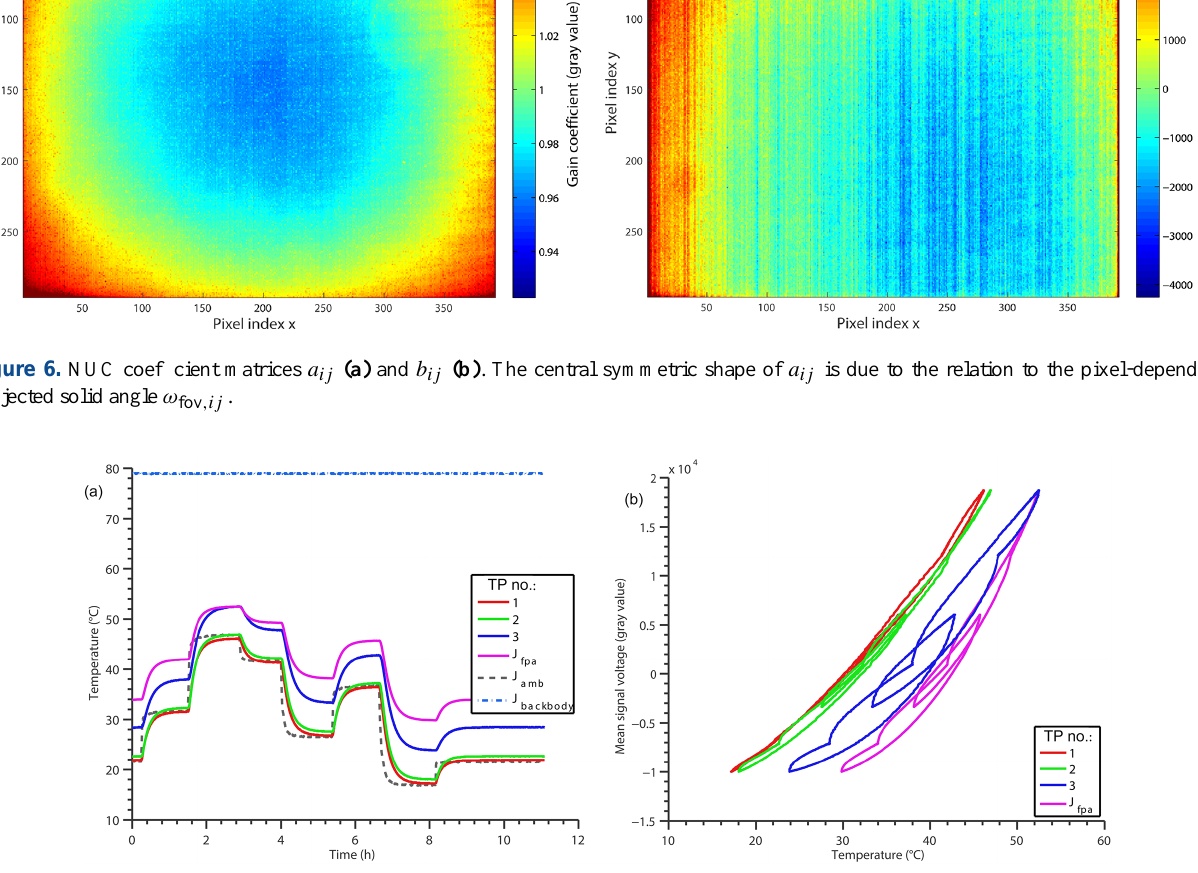
Figure 7. Temperature courses during the offset calibration regime: (a) temperature sensor signals; (b) mean signal voltage versus the four temperature inputs. The shape of the steady-state curves corresponds to a polynomial of the second or third order. The deviations from these steady-state functions are due to the transient behavior during the temperature